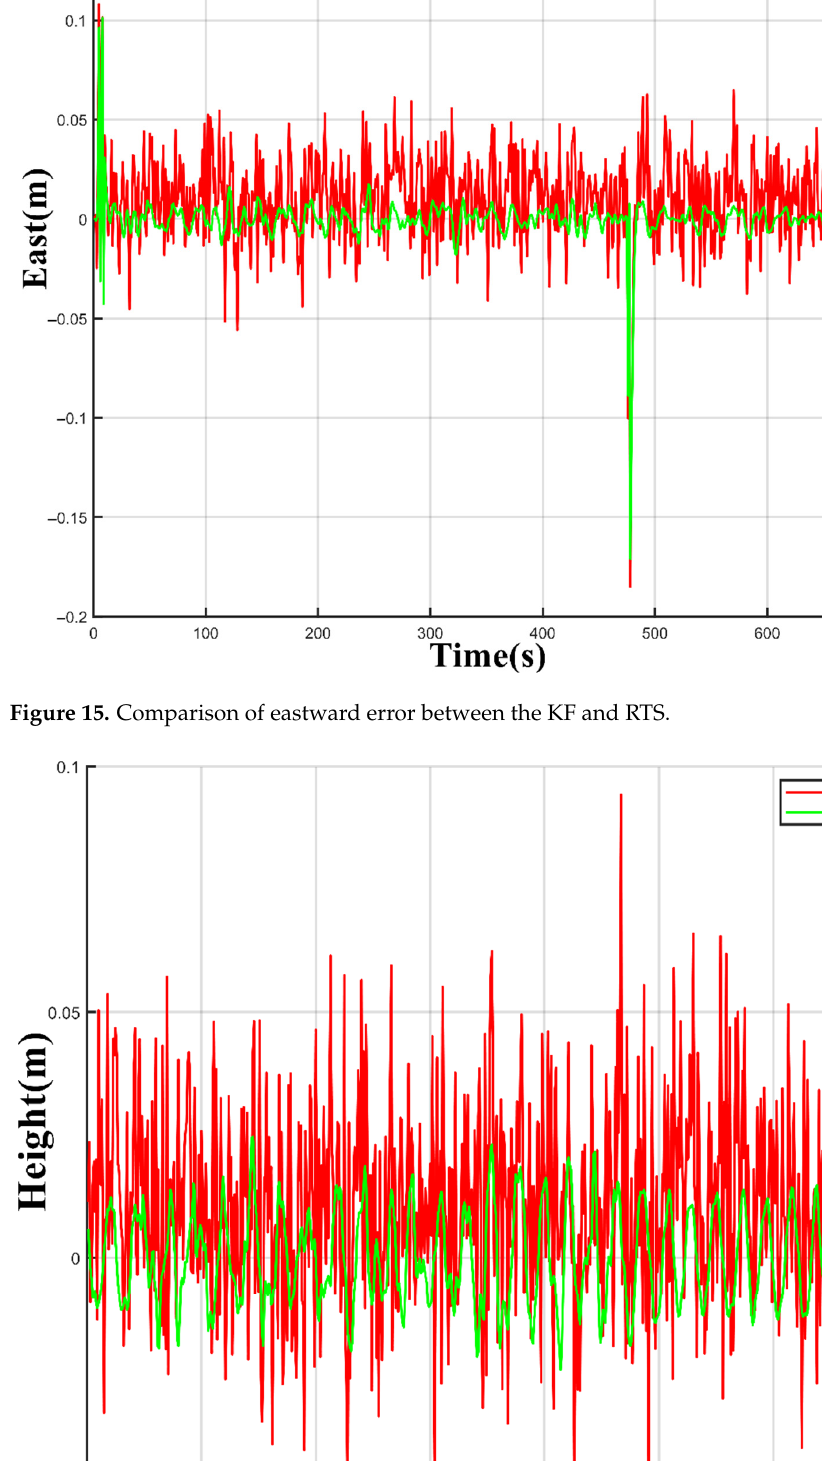
Figure 14. Comparison of northward error between the KF and RTS.